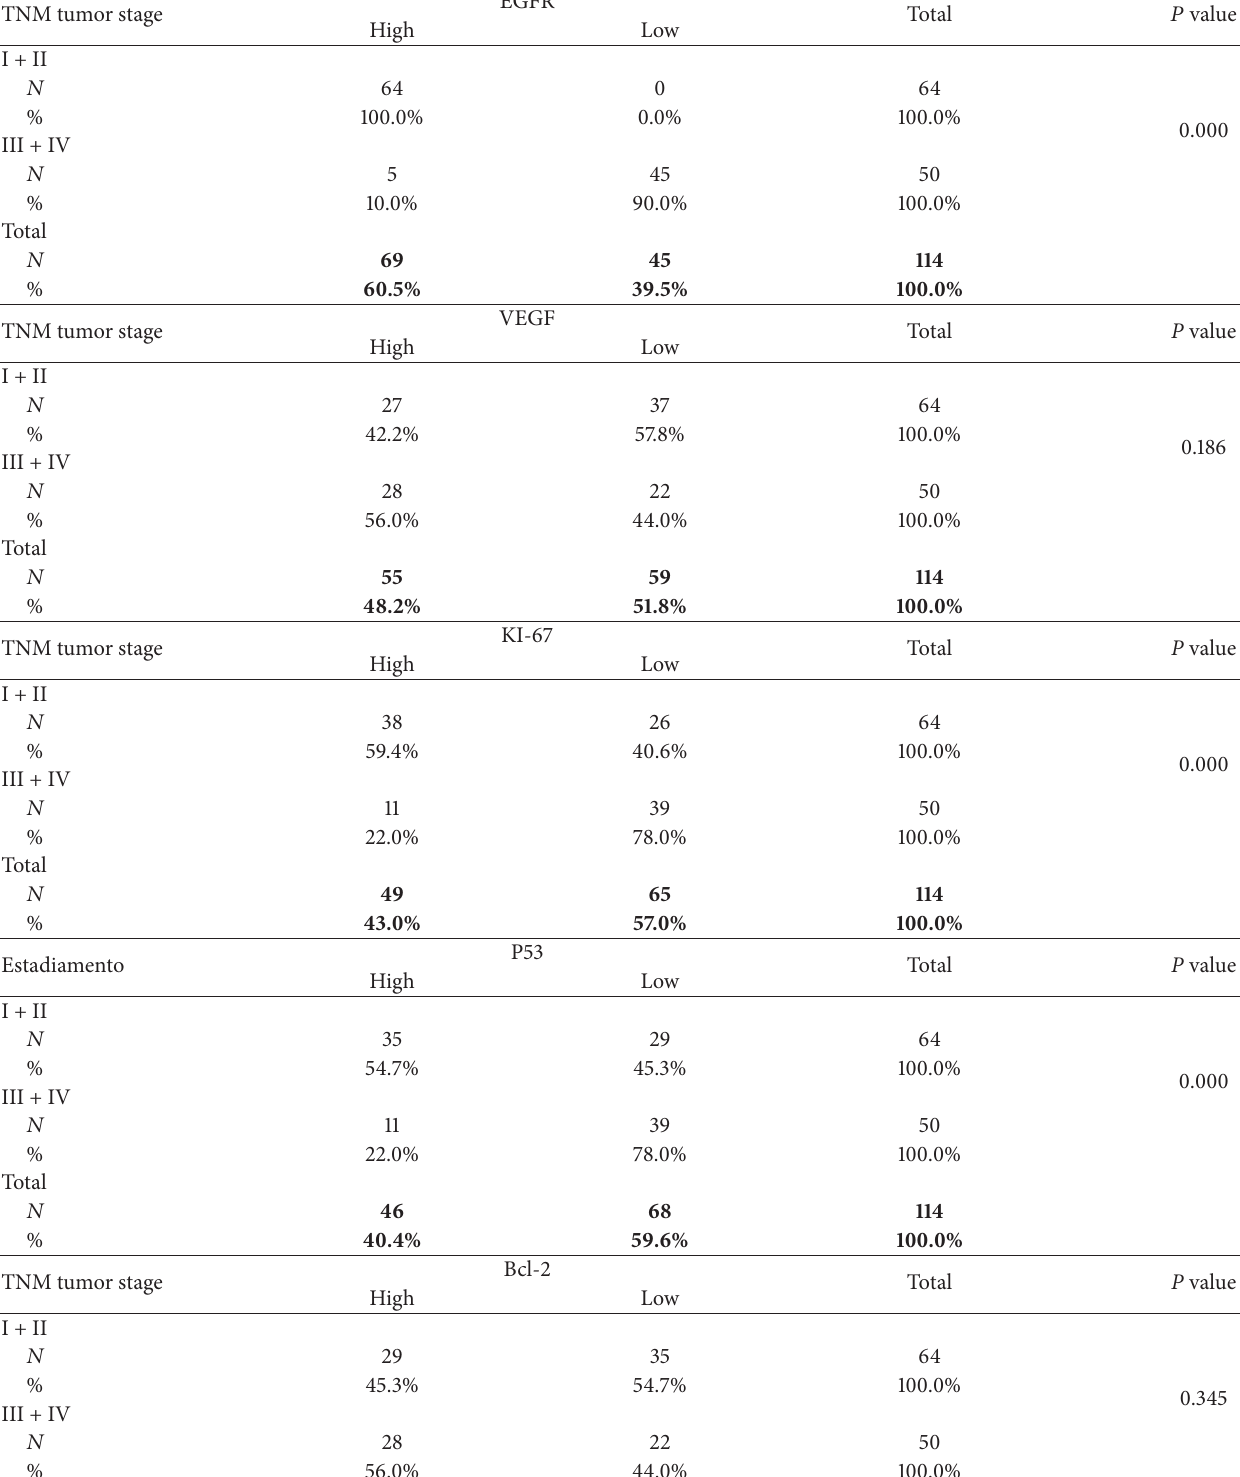
Table 4: The distribution of expression levels per IHC of proteins corresponding to ITGB-5, ITGA-3, MMP-2, MMP-9, and FN-1 ECM genes and EGFR, VEGF, KI-67, P53, and Bcl-2 molecules as per the degree of TNM staging of CRC ( 𝑛 = 114